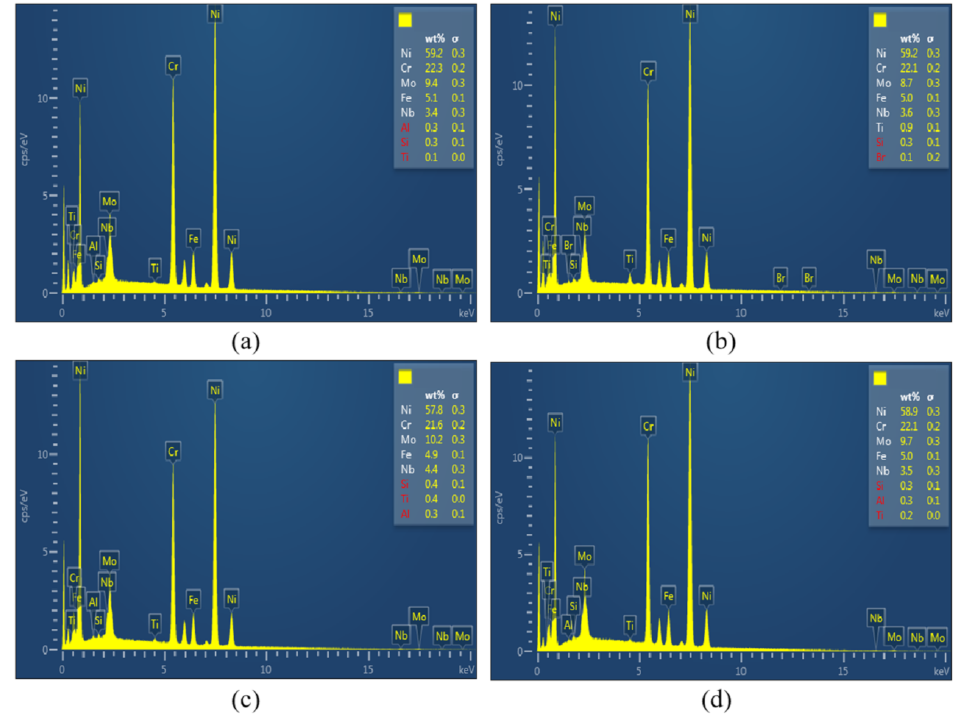
Figure 15. EDS spectra of fracture surface at the ultimate fracture zone for specimens without LSP (( a ) 0.8% strain amplitude, the center of dimple, ( b ) 0.8% strain amplitude, the margin of dimple) and specimens with LSP (( c ) 0.8% strain amplitude, the center of dimple, ( d ) 0.8% strain amplitude, the margin of